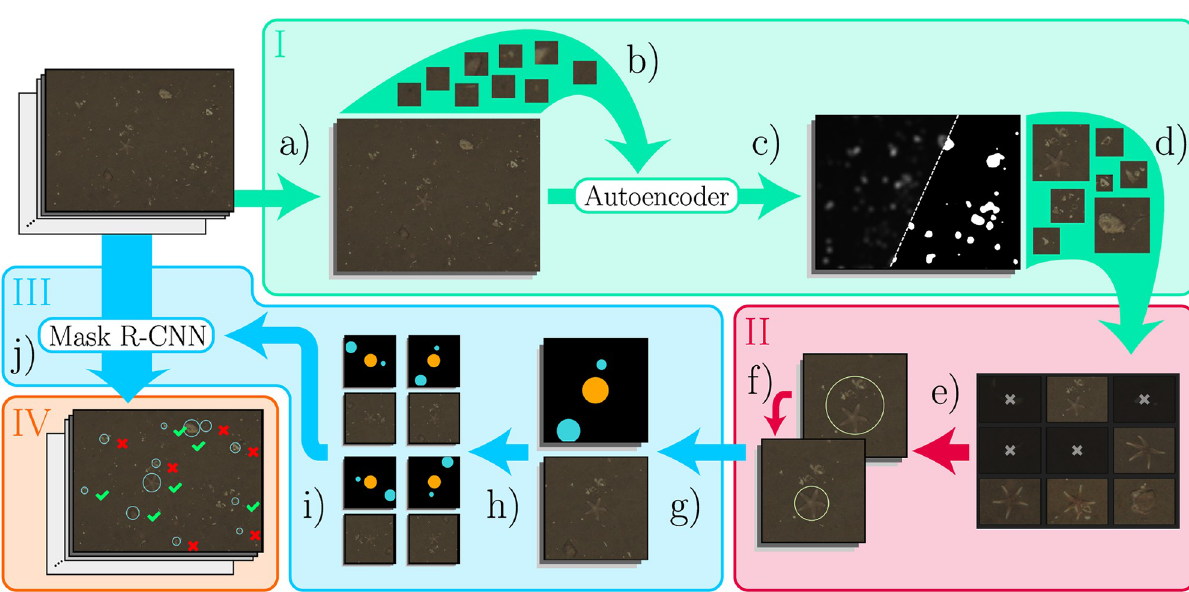
Fig 1. An overview of MAIA. Steps of the four stages are shown in different colors. a) Extraction of a random subset of the images. b) Training of the autoencoder network (AEN) with random image patches extracted from the subset. c) Application of AEN. d) Thresholding of the novelty maps and extraction of interesting regions as training proposals T . e) Manual filtering of T . f) Manual refinement of filtered T . g) Creation of the training p p p dataset T s . h) Boosting of the training dataset. i) Training of Mask R-CNN. j) Detection with Mask R-CNN on the whole image dataset and review of annotation candidates A